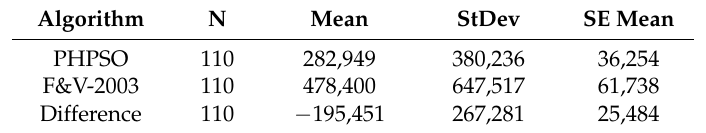
Table 7. Paired t -test for H 0 = PHPSO = F&V vs. H 1 = PHPSO (cid:54) = F&V on the best-known solutions. Algorithm N Mean StDev